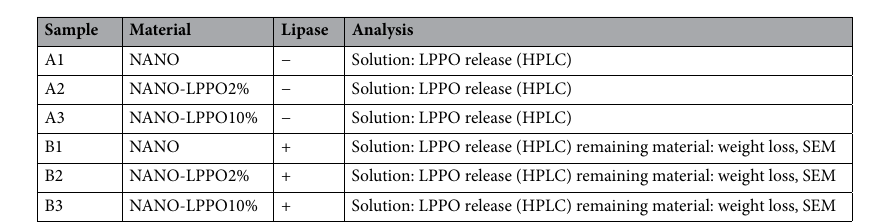
Table 1. Release experiments performed with NANO-LPPO in PBS with/o lipase. LPPO lippophosphonoxin DR-6180, NANO polycaprolactone based nanofiber/wound dressing, PBS phosphate-buffered saline, SEM scanning electron